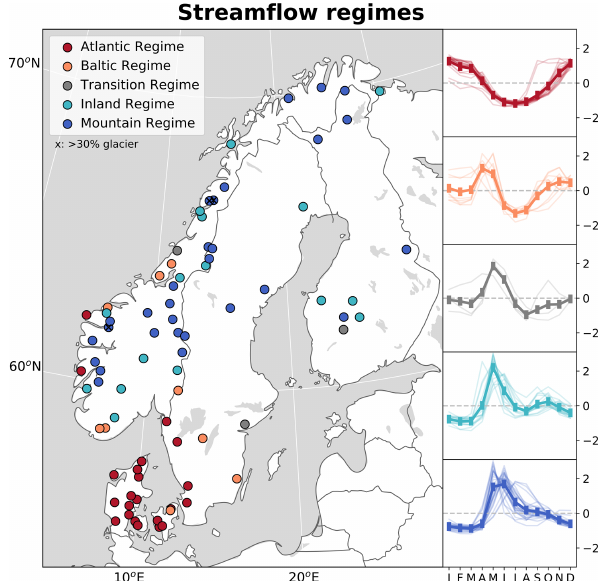
Figure 1. Locations and streamflow regimes (based on Gottschalk et al., 1979) of the 79 streamflow stations used in the study. The right panels show plots of mean monthly standardised (i.e. sub- tracted the mean and divided by the standard deviation) streamflow for each regime (indicated by thin lines) together with the regime mean streamflow (bold line).